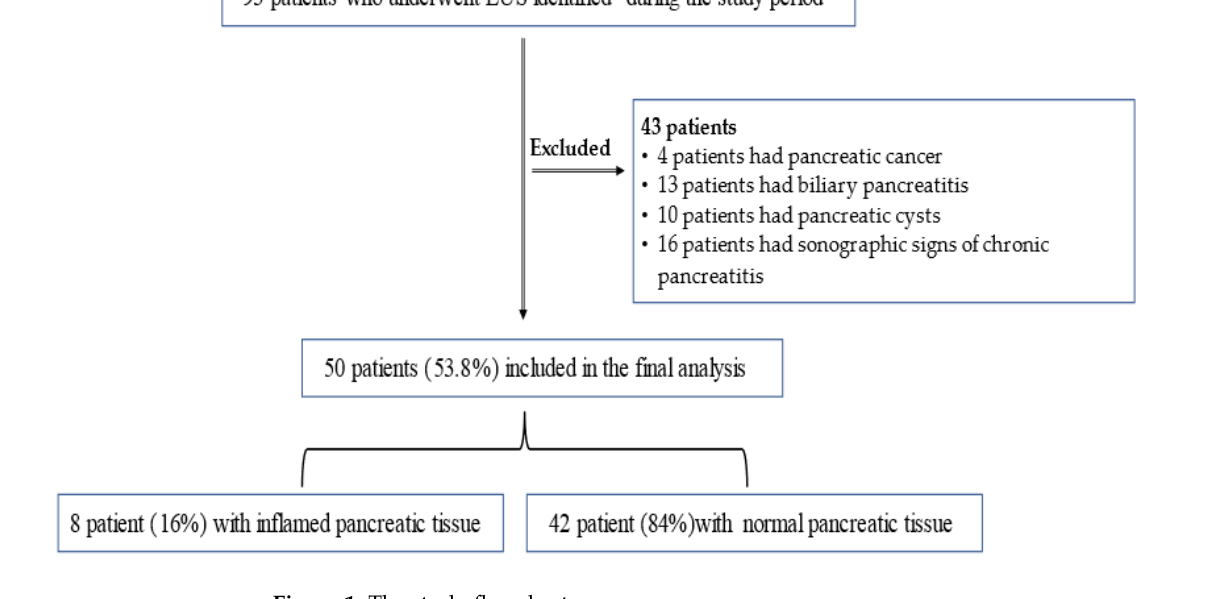
Figure 1. The study flowchart. Table 1. Demographics and clinical characteristics of the entire